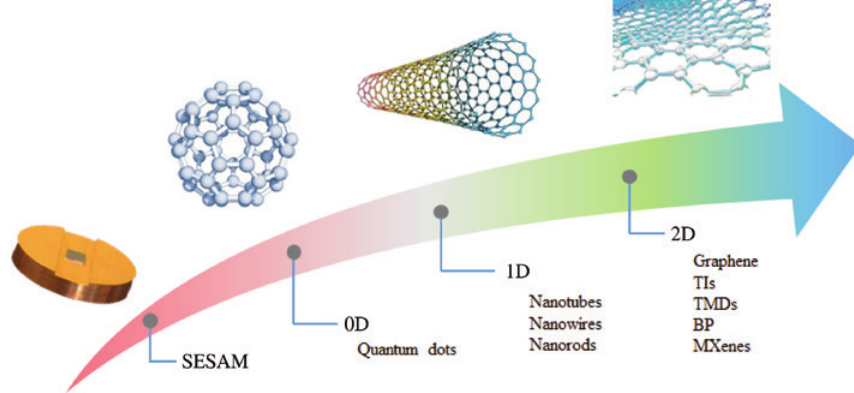
Figure 1: The development of SA ranged from SESAM to LD